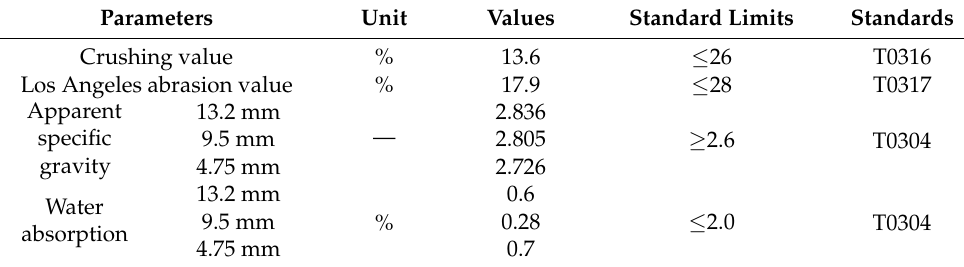
Table 2. Basic physical parameters of coarse aggregate.